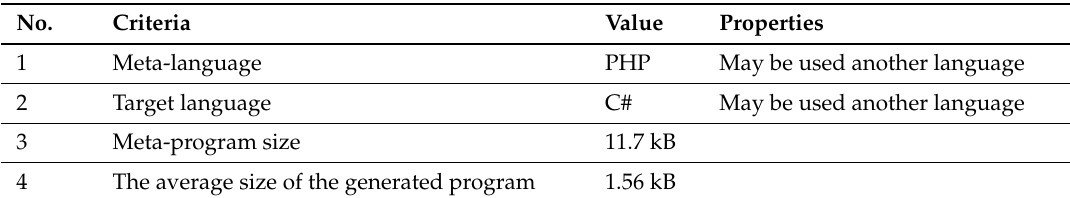
Table 4. Basic metrics of meta-program and its instances for BAN-oriented